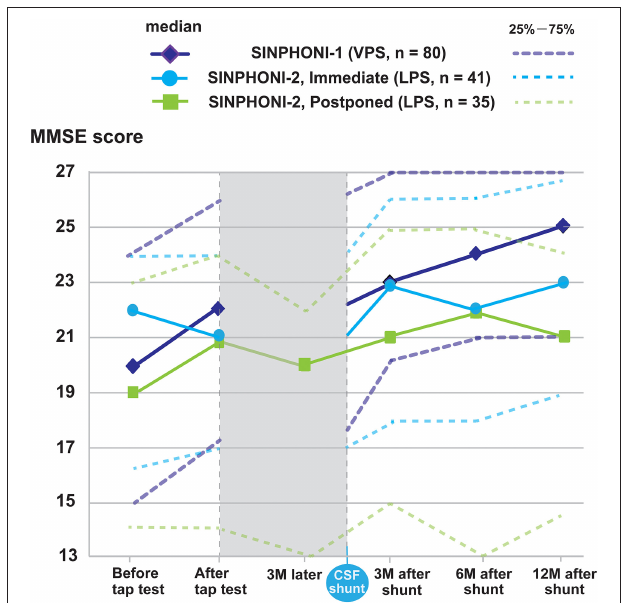
FIGURE 2 | Changes in average MMSE scores for subjects with an MMSE score ≤ 26 during research participation. The changes in MMSE score of the cohort are shown as median MMSE score (solid line), 25–75% (dashed line). In SINPHONI-1, the median MMSE score (25–75%) are 20 (15–24) before tap test (TT), 22 (17–26) after TT, 23 (20–27) at 3 months, 24 (21–27) at 6 months, and 25 (21–27) at 12 months after VPS, respectively. For the immediate group in SINPHONI-2, the median MMSE scores are 22 (16.5–24) before TT, 21 (17–24) after TT, 23 (18–26) at 3, 6 months, and 23 (19–26.75) at 12 months after LPS, respectively. For the postpone group in SINPHONI-2, the median MMSE scores are 19 (14–23) before TT, 21 (14–24) after TT, 20 (13–22) at